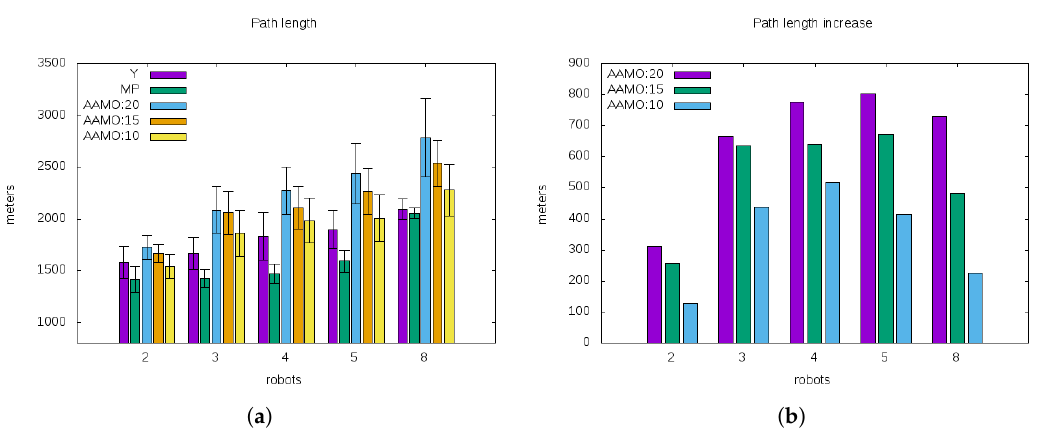
Figure 19. AAMO Path length (PL) under non-ideal communication conditions and Degradation with respect to baseline results. ( a ) An increasing trend of PL is shown by all AAMO instances as the fleet size increase. The Yamauchi and MinPos approach results (coloured in purple and green, respectively) obtained under ideal communication conditions are placed together to make the comparison easier; ( b ) The degradation is expressed in terms of the difference between the PL achieved by each of the AAMO instances and the one achieved by the MinPos approach, for each fleet